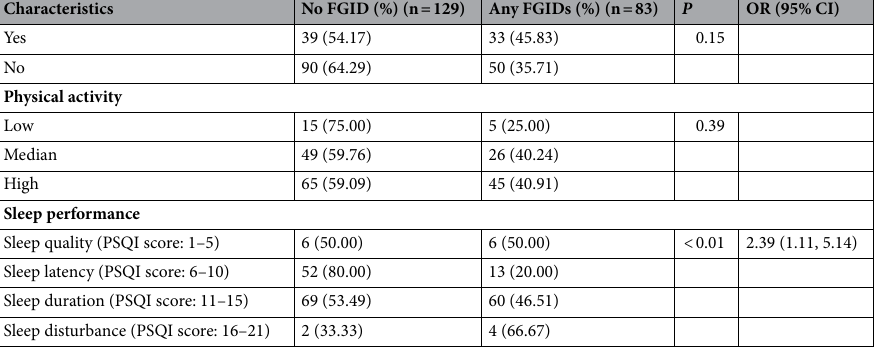
Table 5. Factors associated with functional gastrointestinal disorders. a OR was obtained from stepwise logistic regression